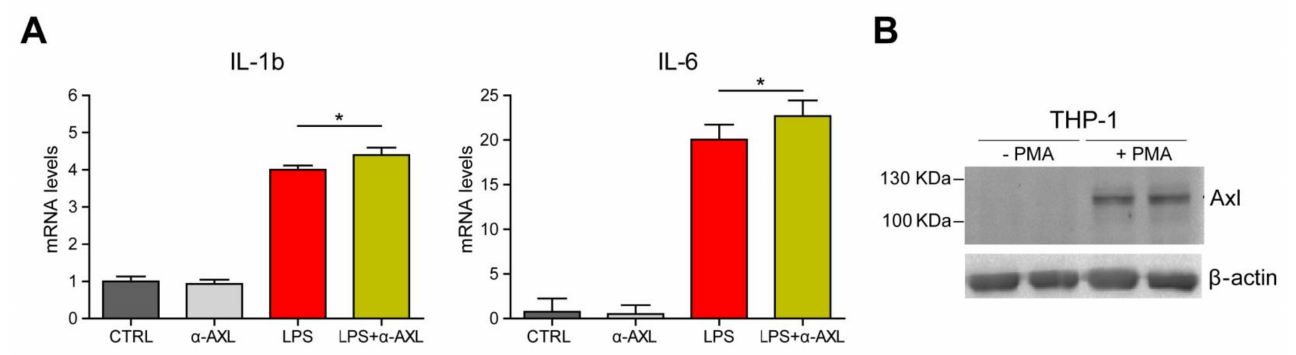
Figure 6. AXL overexpression in activated human macrophages (THP-1 cells) and effect of AXL-activating antibodies on LPS-induced cytokine production. ( A ) PMA-activated THP-1 cells were exposed to LPS (50 ng/mL) and/or pre-incubated for 1 h with an activating goat antihuman AXL polyclonal antibody (10 nM; R&D AF154). mRNA levels of IL-1b and IL-6 were determined 6 h later. Groups were compared using one-way Anova. *, p < 0.05. ( B ) AXL and β -actin protein expression in resting and PMA-activated THP-1 cells was